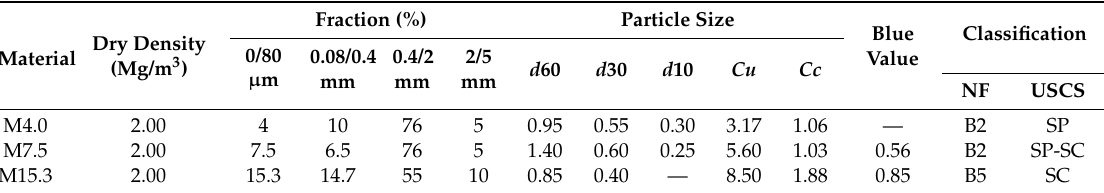
Table 1. Characteristics of the studied